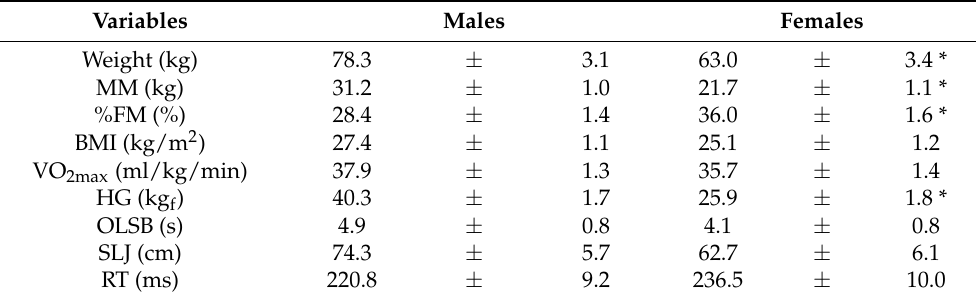
Table 2. Gender differences in body composition and physical fitness variables.